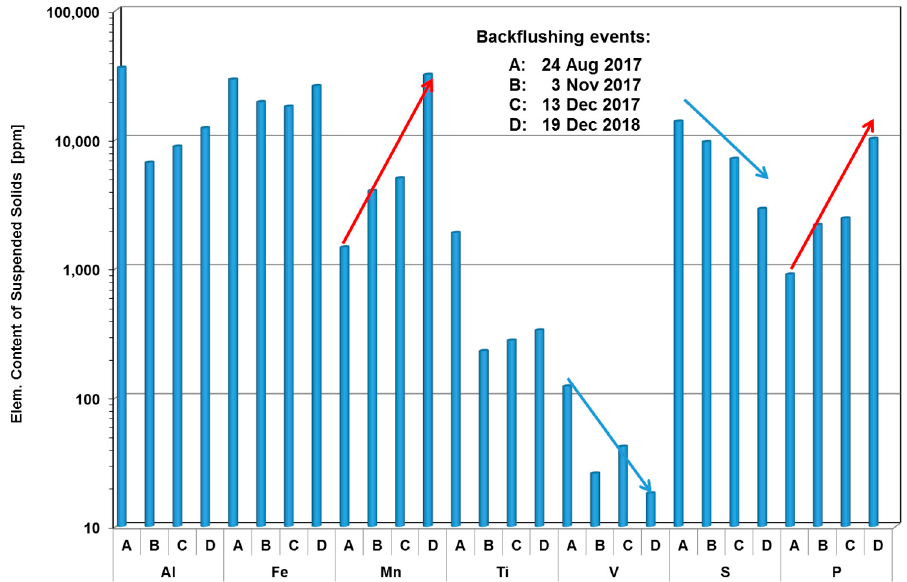
Figure 4. Changes in element content of suspended solids in a sample of backflushed water from ASR well 20 during backflushing events without (A–C) and with prefiltration (D). Based on Table 4. Arrows indicate significant trend over time.